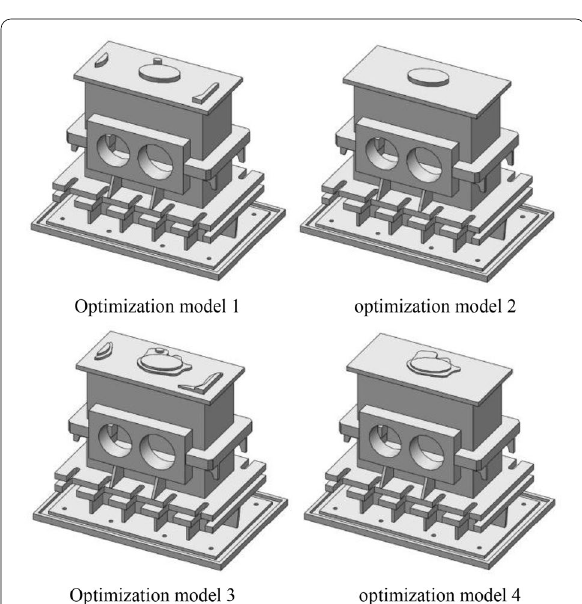
Figure 14 Optimal design model of noise reduction for single-stage gearbox